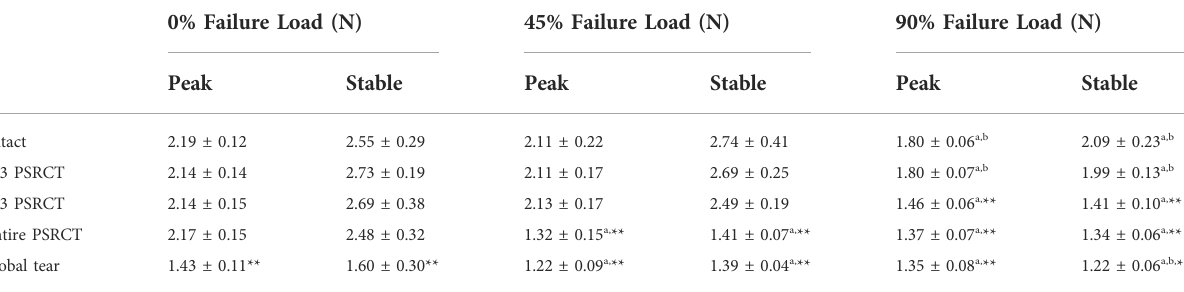
TABLE 3 Effect of RCT on the GHCF/MDF ratio.